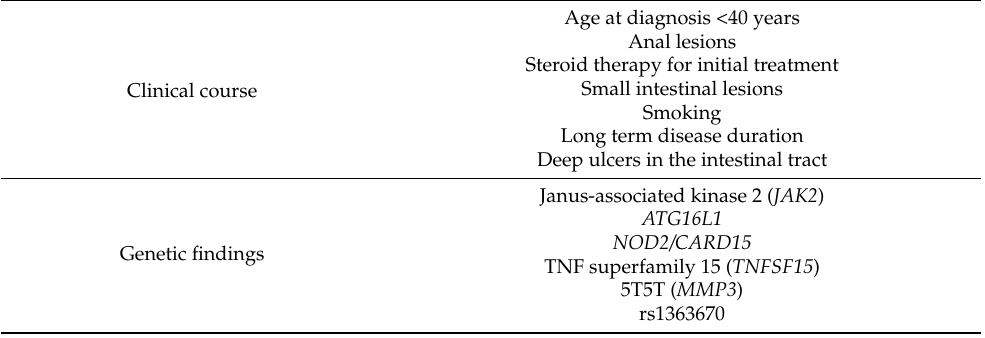
Table 1. Background factors for CD causing intestinal